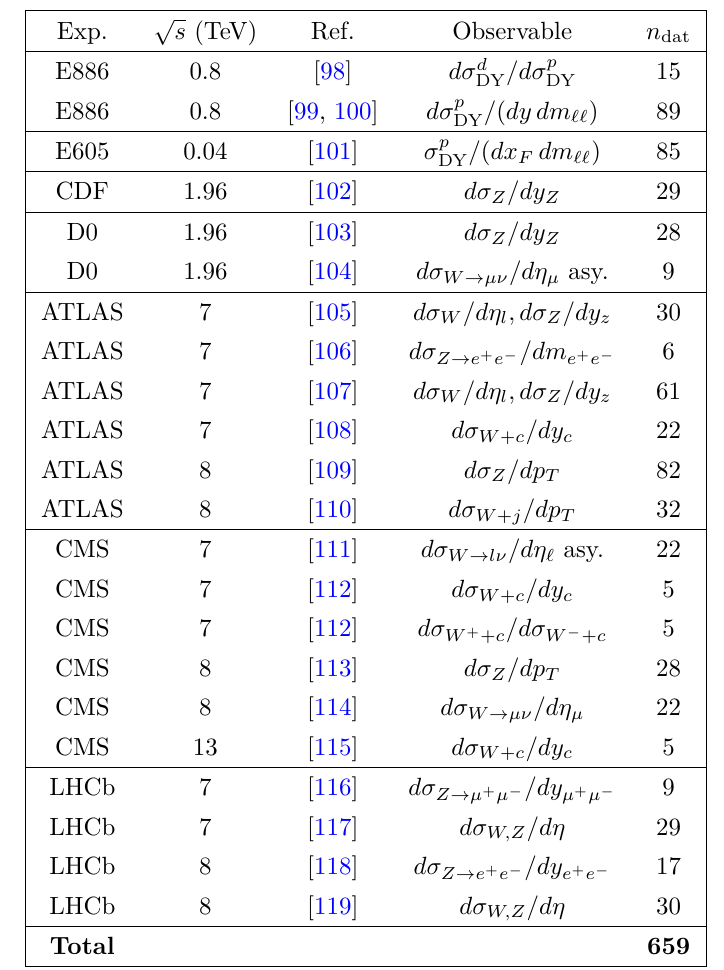
Table 1 . The low-mass and on-shell Drell-Yan datasets used in the present study. For each dataset we indicate the experiment, the centre-of-mass energy observable, and the number of data